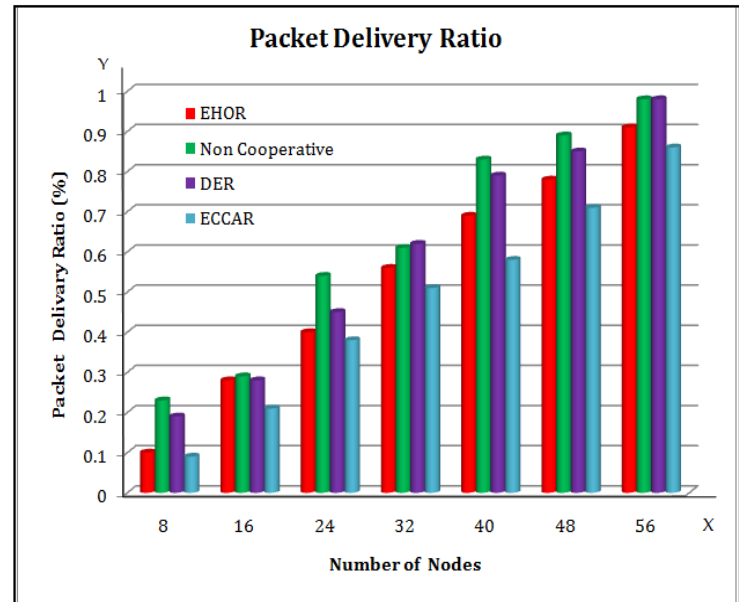
Figure 4. Packet Delivery Ratio.